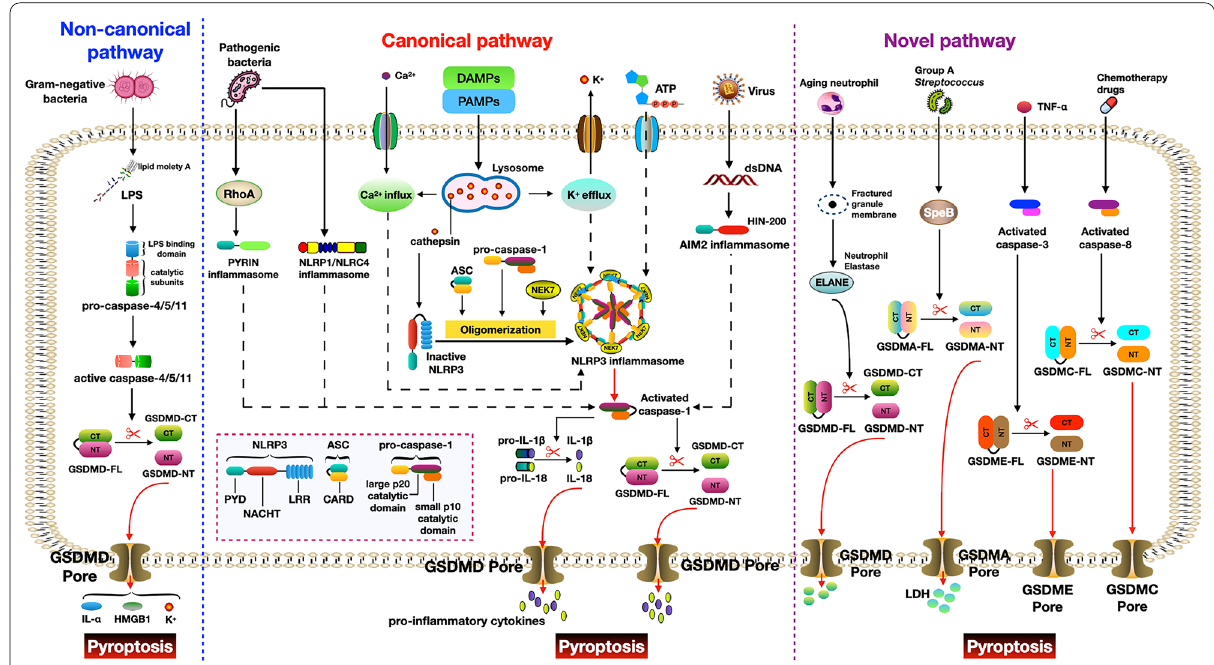
Fig. 1 Molecular mechanisms of pyroptosis. Pyroptosis is a newly identified pro‑inflammatory form of programmed cell death. According to the activation of distinct caspases and execution proteins, pyroptosis can be divided into three types: canonical pathway‑mediated pyroptosis, non‑canonical pathway‑mediated pyroptosis, and novel pathway‑induced pyroptosis. DAMPs, damage ‐ associated molecular patterns; PAMPs, pathogen ‐ associated molecular patterns; NLRP1/3, nucleotide ‐ binding domain, leucine‑rich containing family, pyrin domain ‐ containing 1/3; NLRC4, NLR family CARD domain‑containing 4; AIM2, absent in melanoma 2; NACHT, nucleotide‑binding, and oligomerization; LRR, leucine‑rich repeats; CARD, caspase recruitment domain; PYD, pyrin; ASC, apoptosis‑associated speck‑like protein containing a CARD; GSDMD‑FL, full‑length GSDMD; GSDMD‑CT, C‑terminal GSDMD; GSDMD‑NT, N‑terminal GSDMD; GSDMA‑FL, full‑length GSDMA; GSDMA‑CT, C‑terminal GSDMA; GSDMA‑NT, N‑terminal GSDMA; GSDME‑FL, full‑length GSDME; GSDME‑CT, C‑terminal GSDME; GSDME‑NT, N‑terminal GSDME; RhoA, Ras homologous A; SpeB, streptococcus exotoxin B; ELANE, neutrophil elastase; HMGB1, high mobility group box